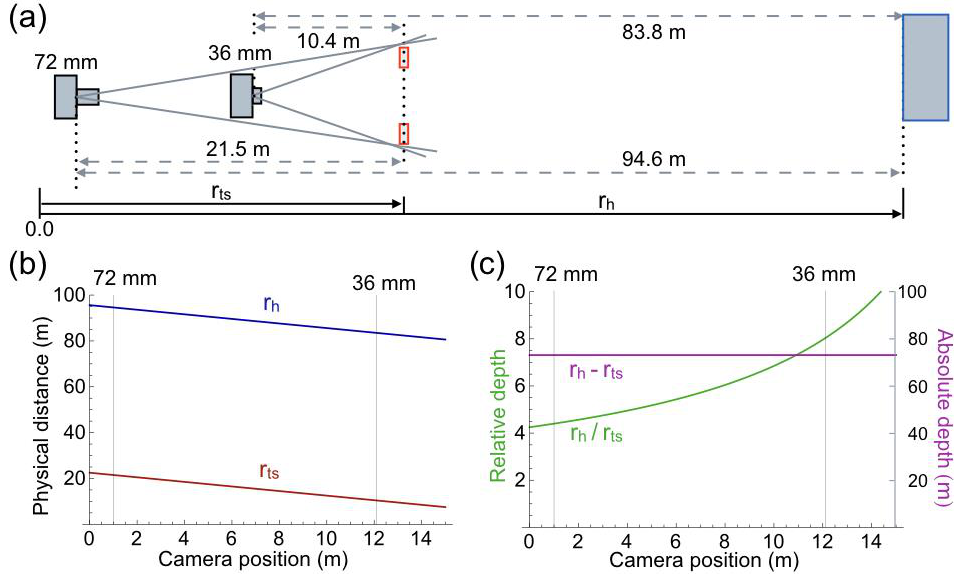
Figure 2. Geometry of the physical scene depicted in Figure 1a and Figure 1b. ( a ) Top view of the scene. Sizes and distances of objects are not to scale. Distances were computed of traffic signs (r ts ) and house (r h ) relative to the positions from which the pictures were taken. ( b ) Distance of traffic signs (r ts ) and house (r h ) as function of camera position. The arbitrary origin of the x-axis is chosen 1 m from the FL 72 mm camera position. Thin vertical lines mark the two camera positions from which the pictures were taken. ( c ) Relative (green) and absolute (magenta) depth between traffic signs and house computed as function of camera position.